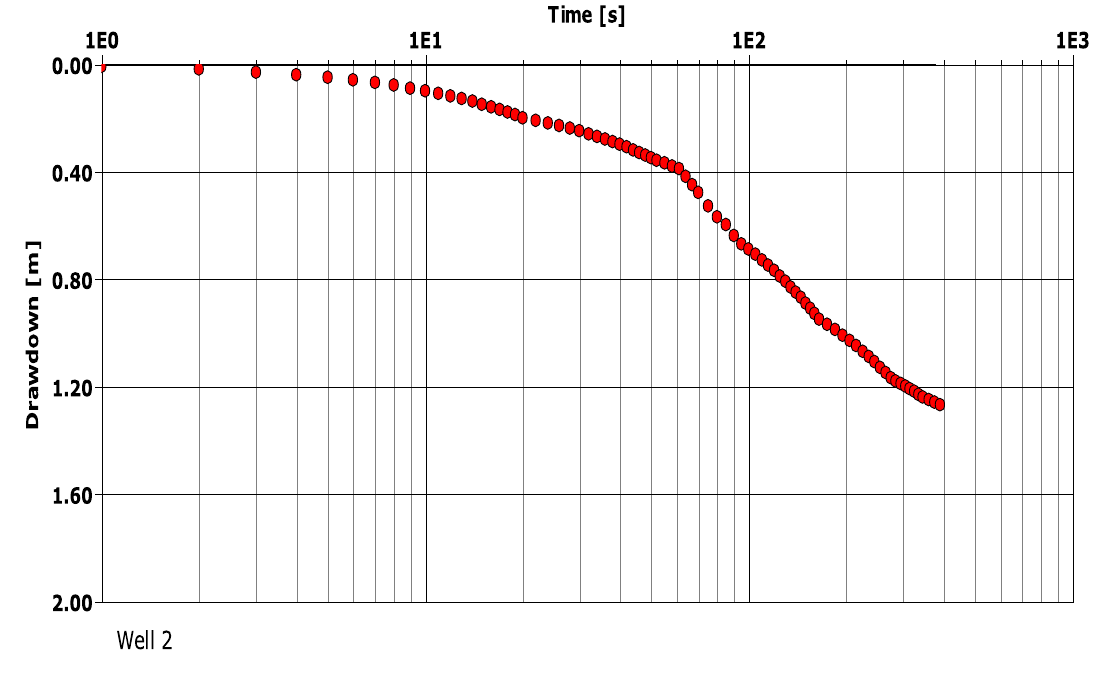
Fig. 19 Theis’s method of pumping well-2